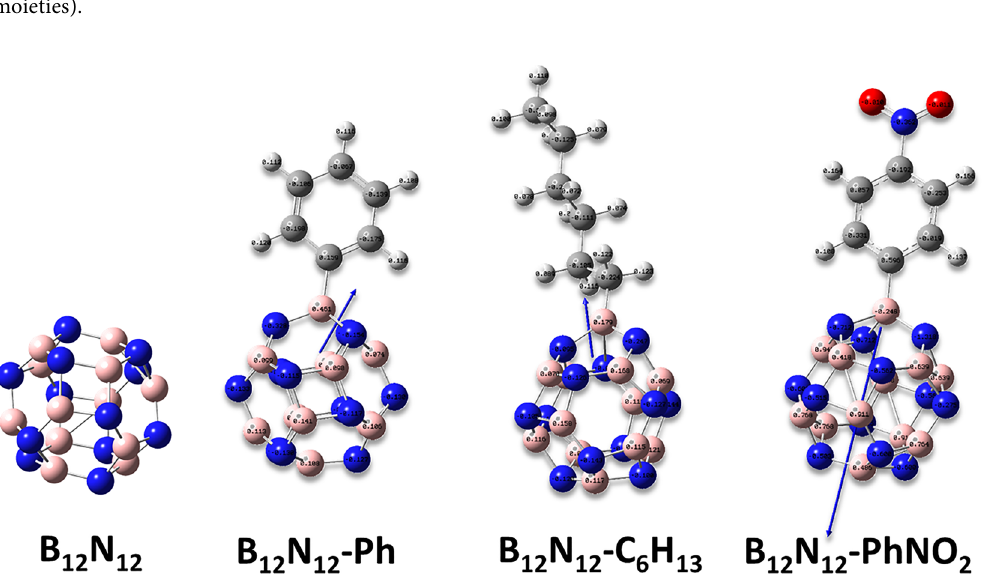
Figure 3. The orientation of the dipole moment of the bare and grafted B 12 N 12 nanocage cluster.